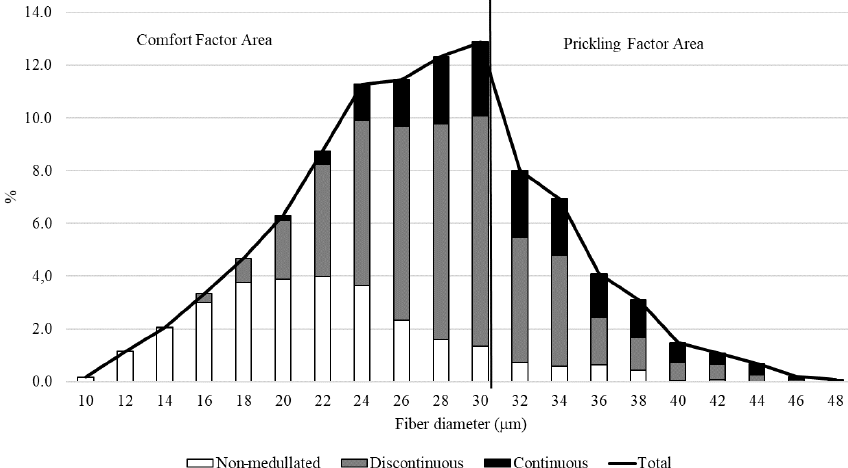
Figure 4. The fiber category distribution within the fiber diameter classes in the wool of the alpacas